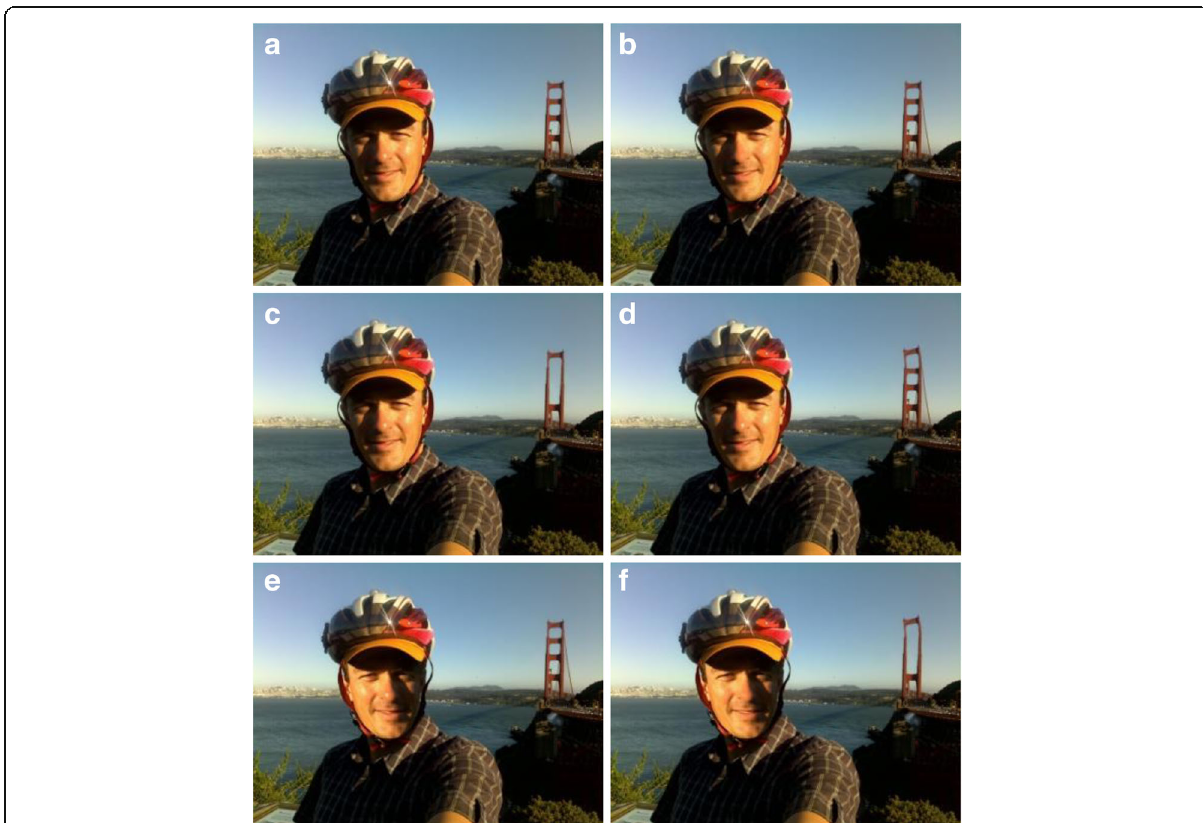
Fig. 1 Samples of manipulated photos. a Original photo; b airbrushing — removal of sweat on the nose, cheeks, and chin, and removal of wrinkles around the eyes; c addition or subtraction — two links between the columns of the tower of the suspension bridge removed; d geometrical inconsistency — top of the bridge is sheered at an angle inconsistent with the rest of the bridge; e shadow inconsistency — face is flipped around the vertical axis so that the light is on the wrong side of the face compared with lighting in the rest of the scene; f super-additive — combination of all previously described